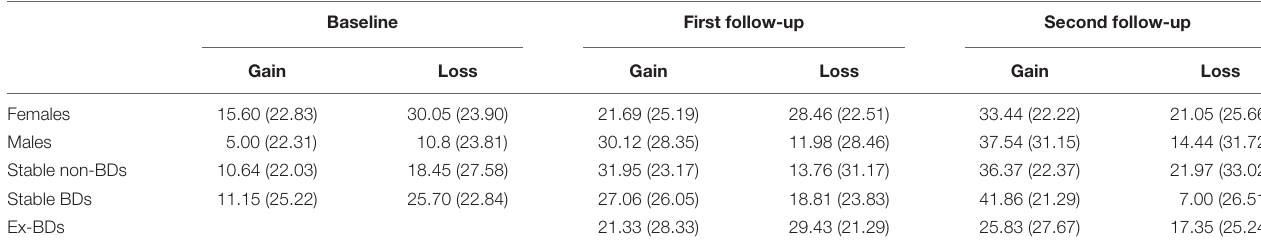
TABLE 2 | Means (and standard deviations) for net gain and loss over